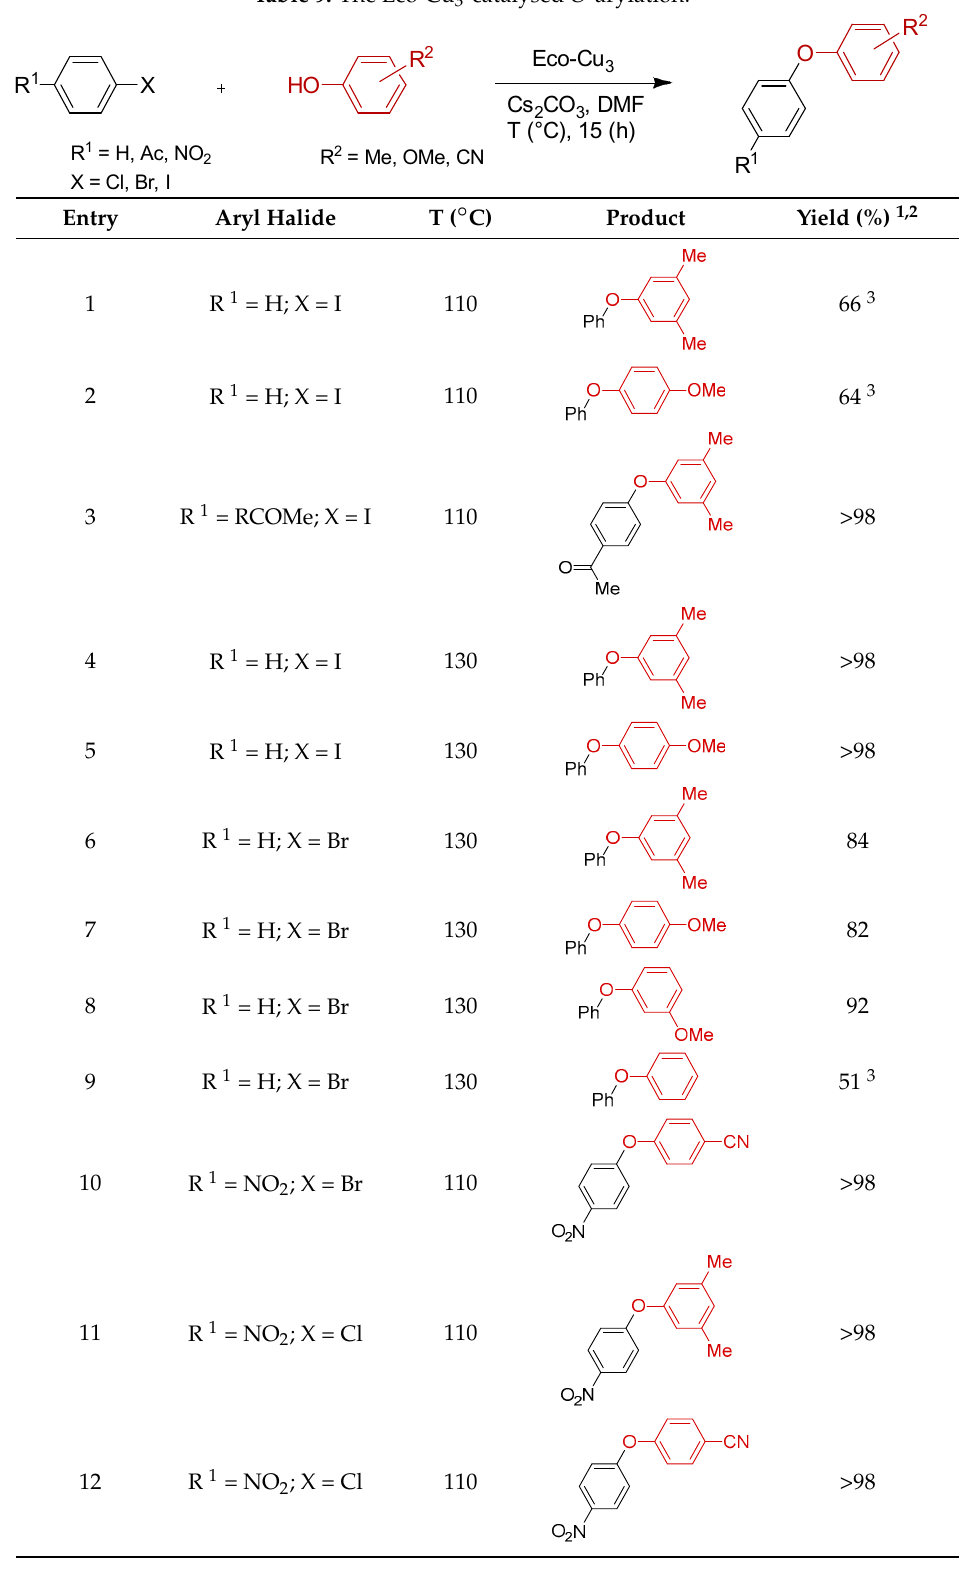
Table 9. The Eco-Cu 3 -catalysed O -arylation.